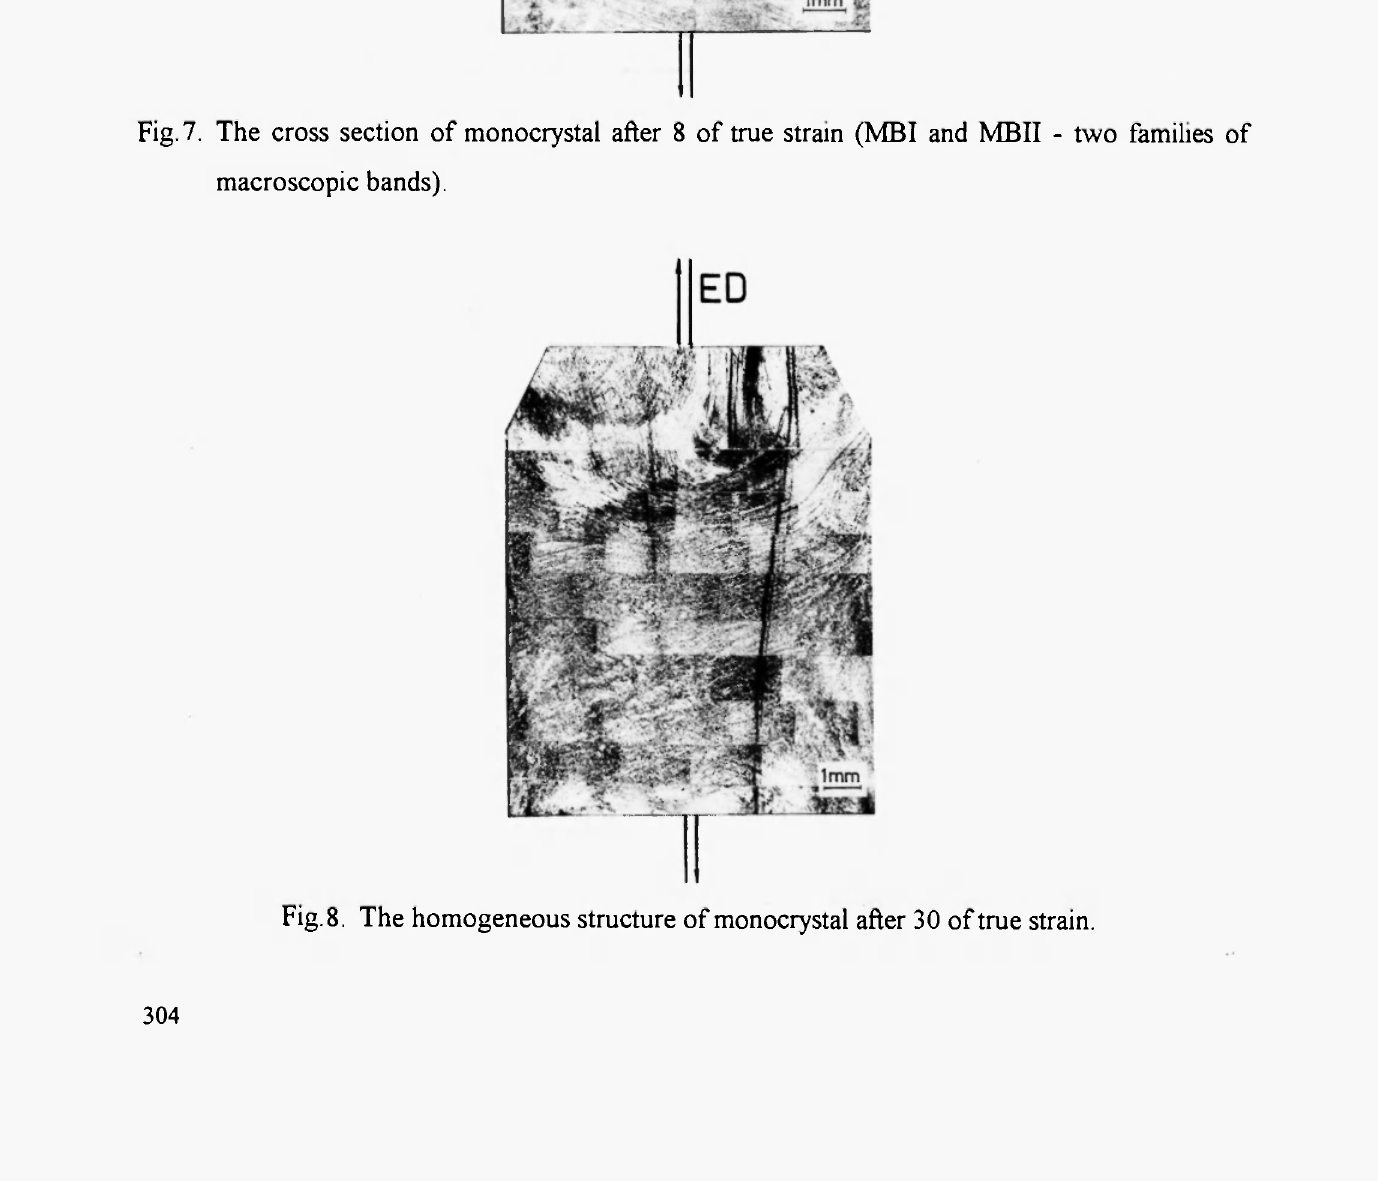
Fig. 7. The cross section of monocrystal after 8 of true strain (MBI and MBII - two families of macroscopic bands).